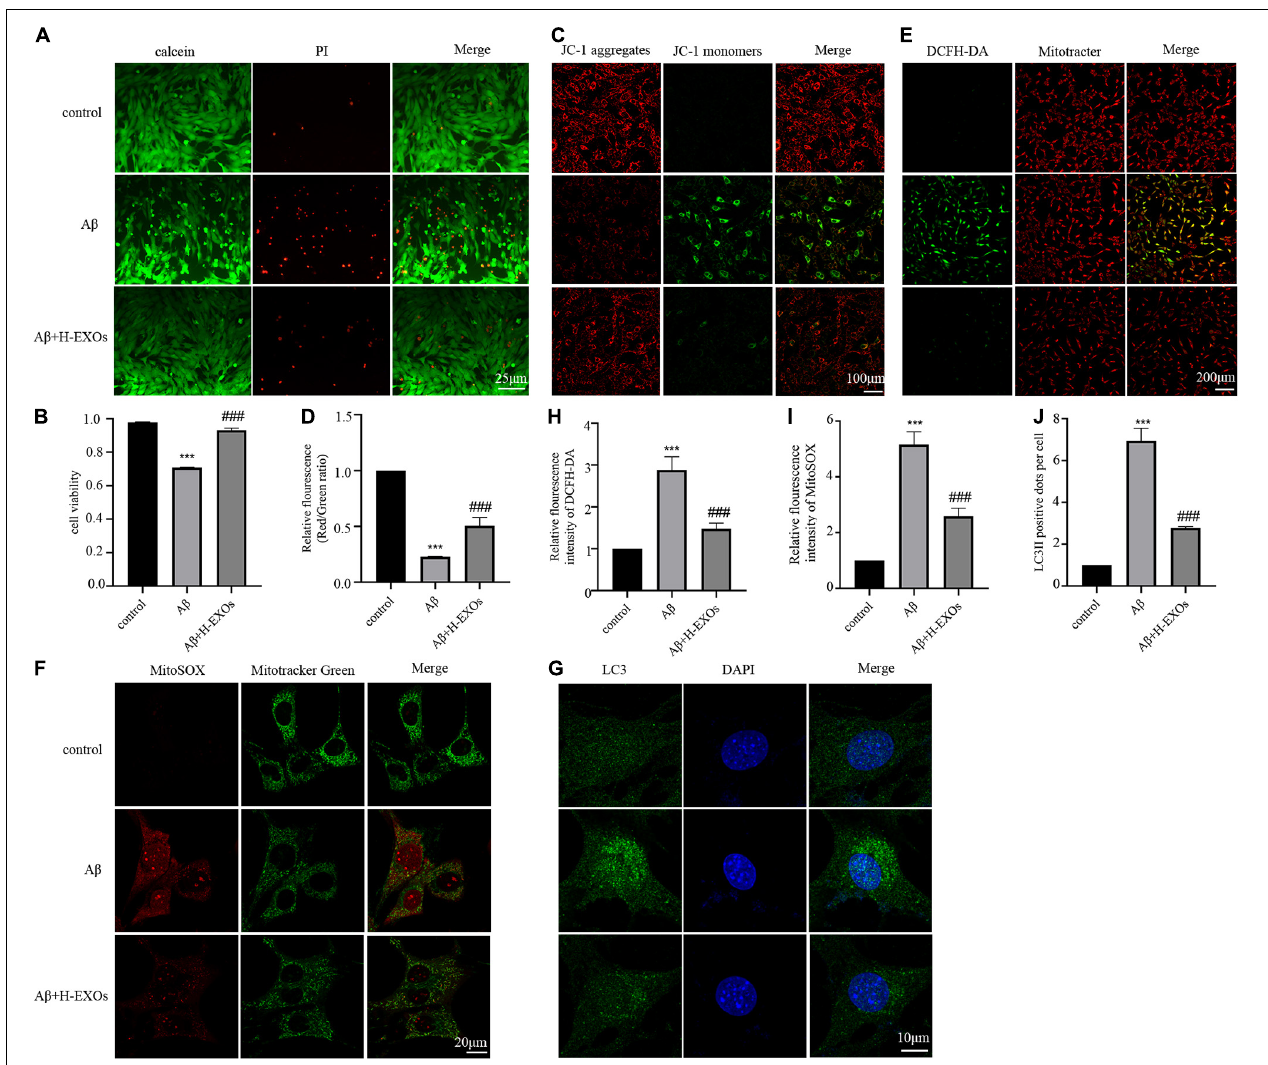
FIGURE 5 | M2-EXOs alleviated cell apoptosis and mitochondrial impairment of the AD cell model. (A) Cell viability observed by calcein/PI staining with or without M2-EXO administration. (B) Quantitative analysis of Fig A. (C) Representative JC-1 staining images with or without M2-EXO administration. (D) Quantitative analysis of JC-1 fluorescence intensity. (E) Representative DCFH-DA staining images with or without M2-EXO administration. (F) Representative MitoSOX staining images with or without M2-EXO administration. (G) Representative images of LC3 immunofluorescence with or without M2-EXO administration. (H–J) Quantitative analysis of the fluorescence intensity of DCFH-DA, MitoSOX, and LC3. All experiments were repeated three times. *** P < 0.001 vs. control, ### P < 0.001 vs. A β